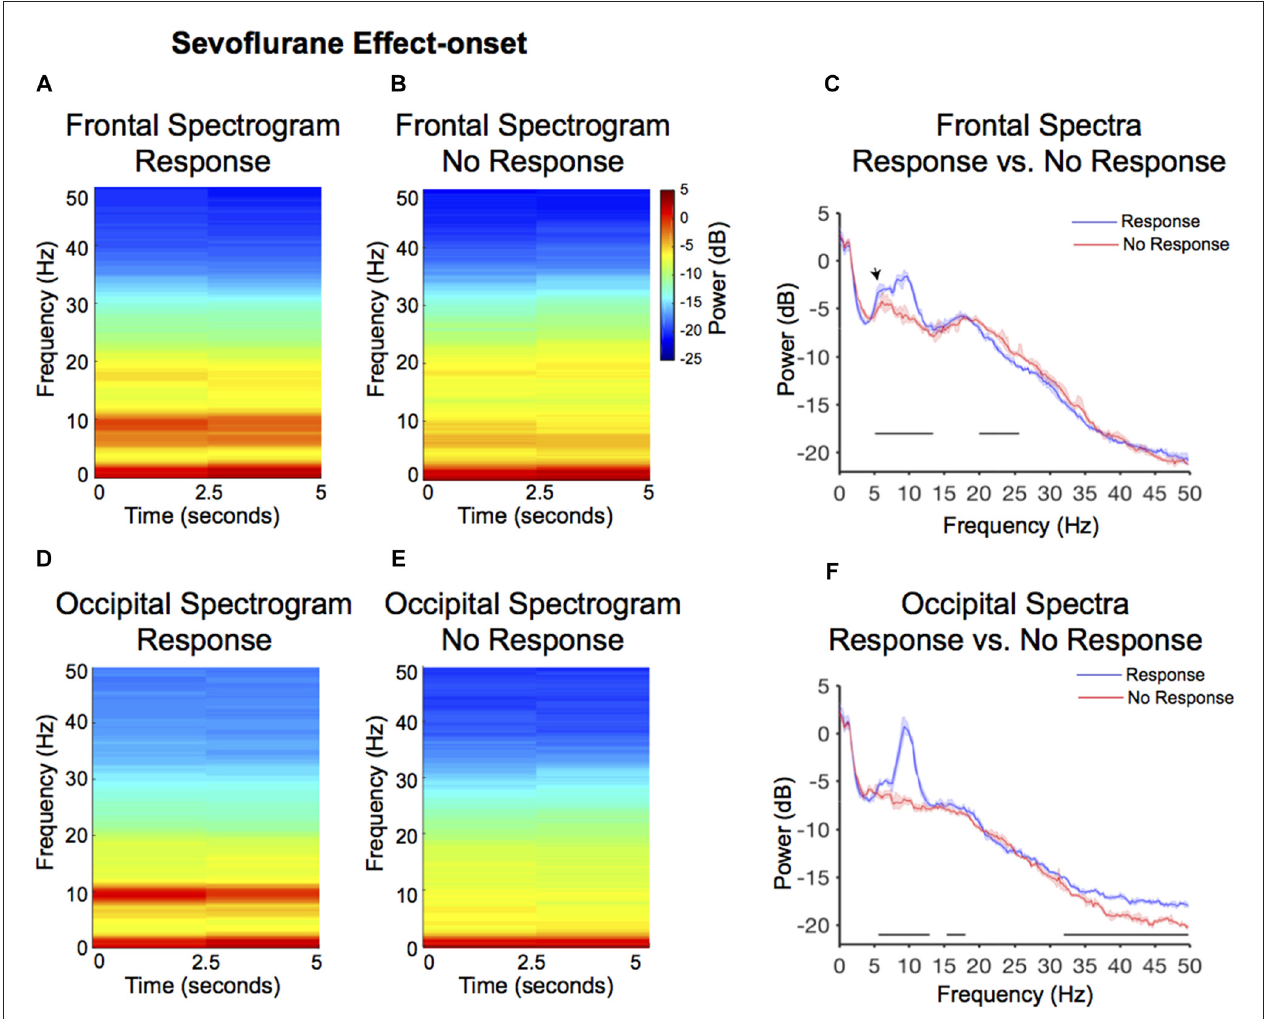
FIGURE 3 | Spectral comparison of response vs. no-response curves during anesthesia effect-onset. (A,B) Median frontal spectrograms of response and no-response ( n = 8). (C) Overlay of median response frontal spectrum (blue), and median no-response frontal spectrum (red). Bootstrapped median spectra are presented, and the shaded regions represent the 99% confidence interval for the uncertainty around each median spectrum. We observed differences in power among frequency bands within response and no-response spectra ( Table 1 ). Black lines represent statistically significant frequencies. (D,E) Median occipital spectrograms of response and no-response ( n = 8). (F) Overlay of median response occipital spectrum (blue), and median no response occipital spectrum (red), with shaded regions showing the 99% confidence interval for uncertainty around each bootstrapped median spectrum. We observed differences in power among frequency bands within response and no-response spectra ( Table 1 ). Black lines represent statistically significant